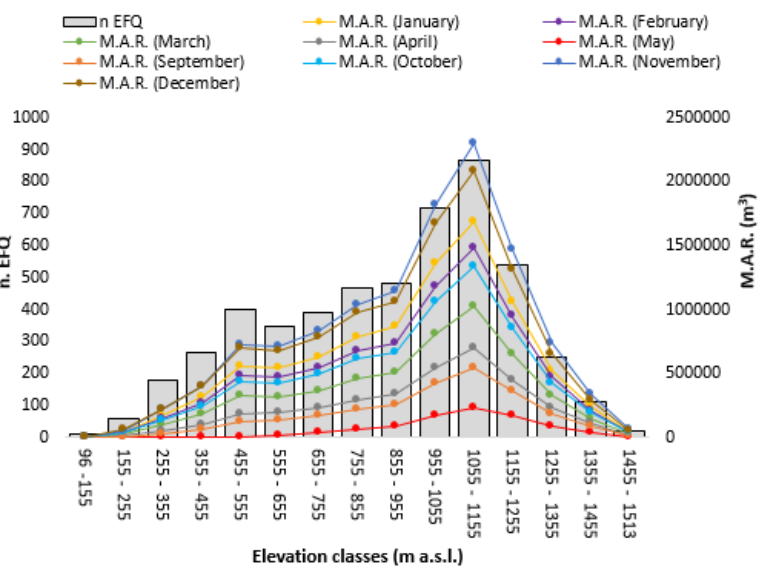
Figure 15. Monthly average recharge (M.A.R.) distribution of the different months on elevation clas- ses of Capodacqua di Spigno basin (June, July and August are absent because they have zero infil- tration); and elevation classes’ distribution of Capodacqua di Spigno basin in terms of topographic surface (in grey). surface (in grey).